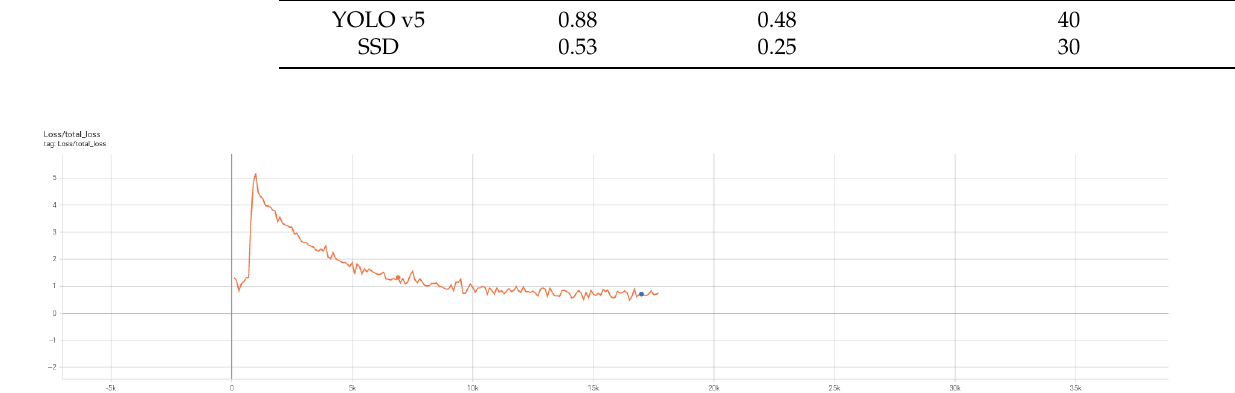
Figure 10. The total loss function curve for the SSD-RestNet model.